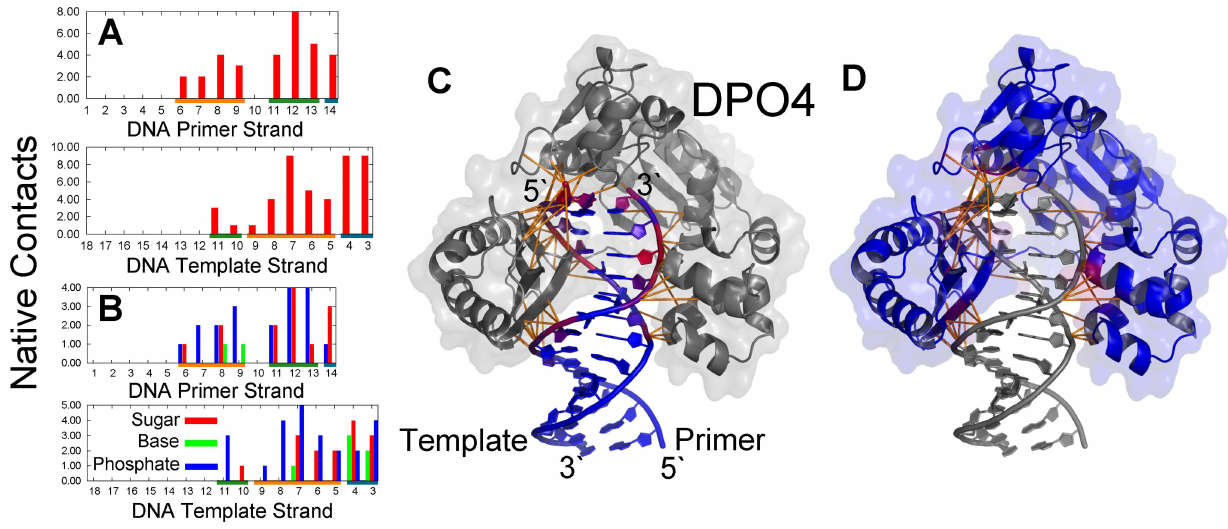
Figure 9. Native contacts between DPO4 and DNA in native bound structure. (A) Native contacts for each nucleotide in DNA. DPO4 interacts with DNA in native bound structure at three different regions, which are colored orange, olive green and dark cyan, corresponding to the major groove, minor groove and the terminal of the DNA duplex, respectively. (B) Native contacts for the sugar, base and phosphate group in DNA. (C, D) The native structure of DPO4-DNA binary complex. In (C), the sugar, base and phosphate groups in DNA are colored from blue to red, corresponding to contact number from 0 to 5; while DPO4 is colored grey. In (D), the residues in DPO4 are colored from blue to red, corresponding to the DPO4-DNA contact number from 0 to 5, while DNA is colored grey. The DPO4-DNA contacts are drawn by orange lines in (C) and